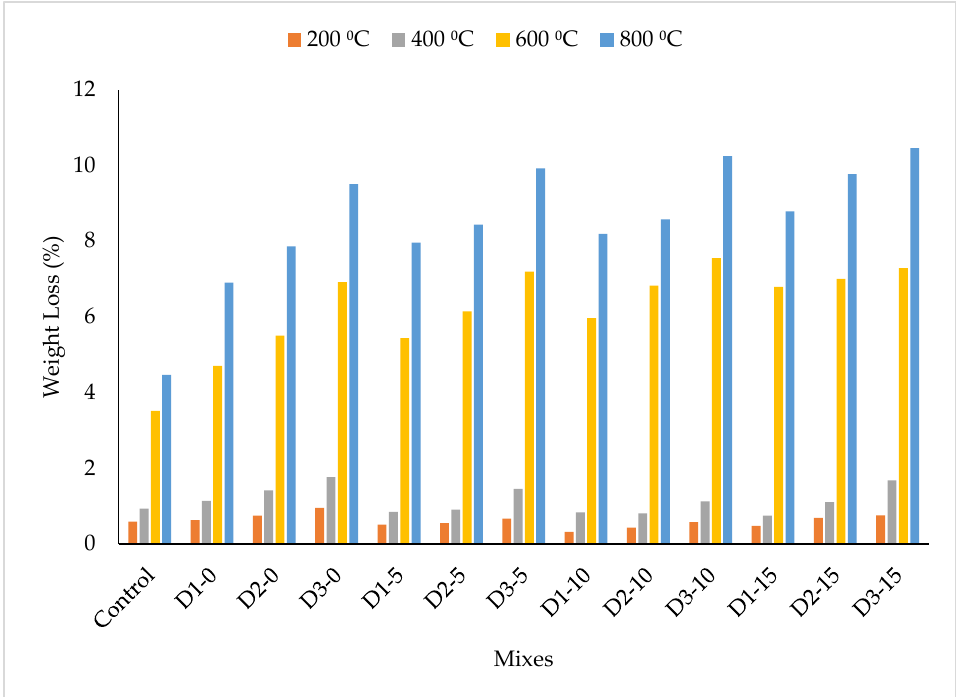
Figure 3. Weight loss caused by elevated temperatures.